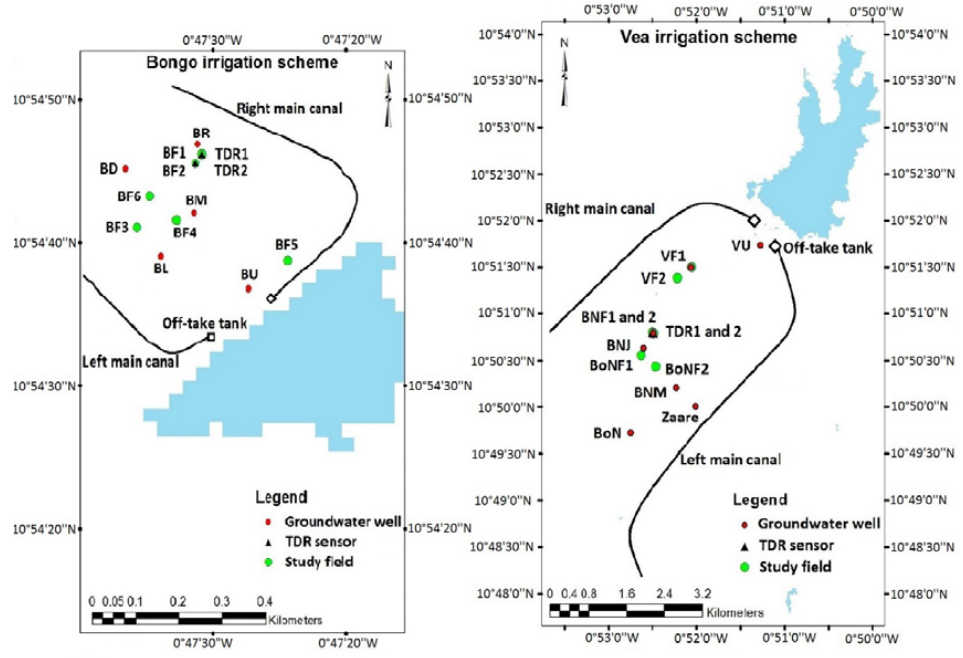
Figure 3. Layout of the irrigation schemes (reproduced from Sekyi-Annan et al. [19]). BF1–6 = Bongo fields, BNF1, 2 = Bongo Nyariga fields, BoNF1, 2 = Bolga Nyariga fields, BR = Bongo right well, BL = Bongo left well, BM = Bongo middle well, BD = Bongo downslope well, BU = Bongo upslope well, VF1, 2 = Vea fields, VU = Vea upslope well, BNM = Bongo Nyariga middle well, BNJ = Bongo Nyariga junction well, TDR1, 2 = Time domain reflectometers.